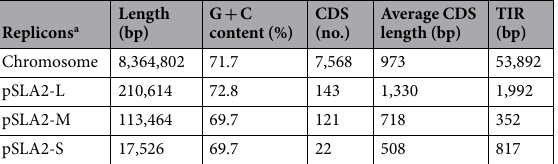
Table 2. General features of the chromosome and three plasmids of S. rochei 7434AN4. a GenBank accession